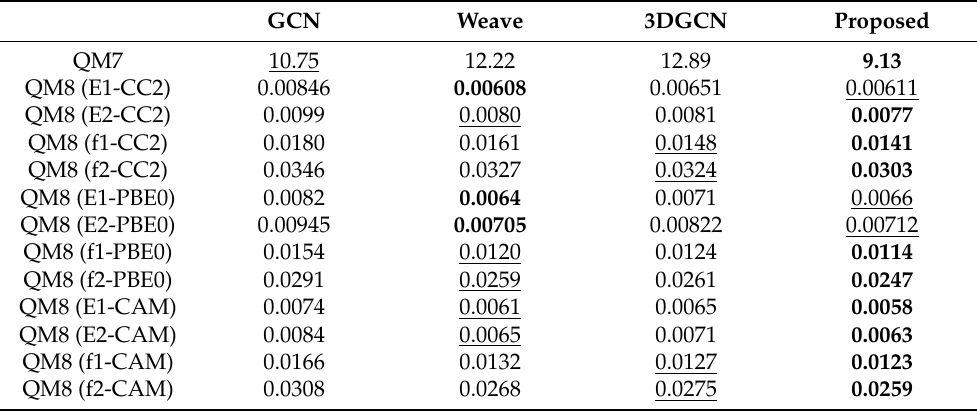
Table 3. Averages of MAE over 10 trials on quantum mechanism datasets (Bold and underline are the best and the second-best, respectively). GCN Weave